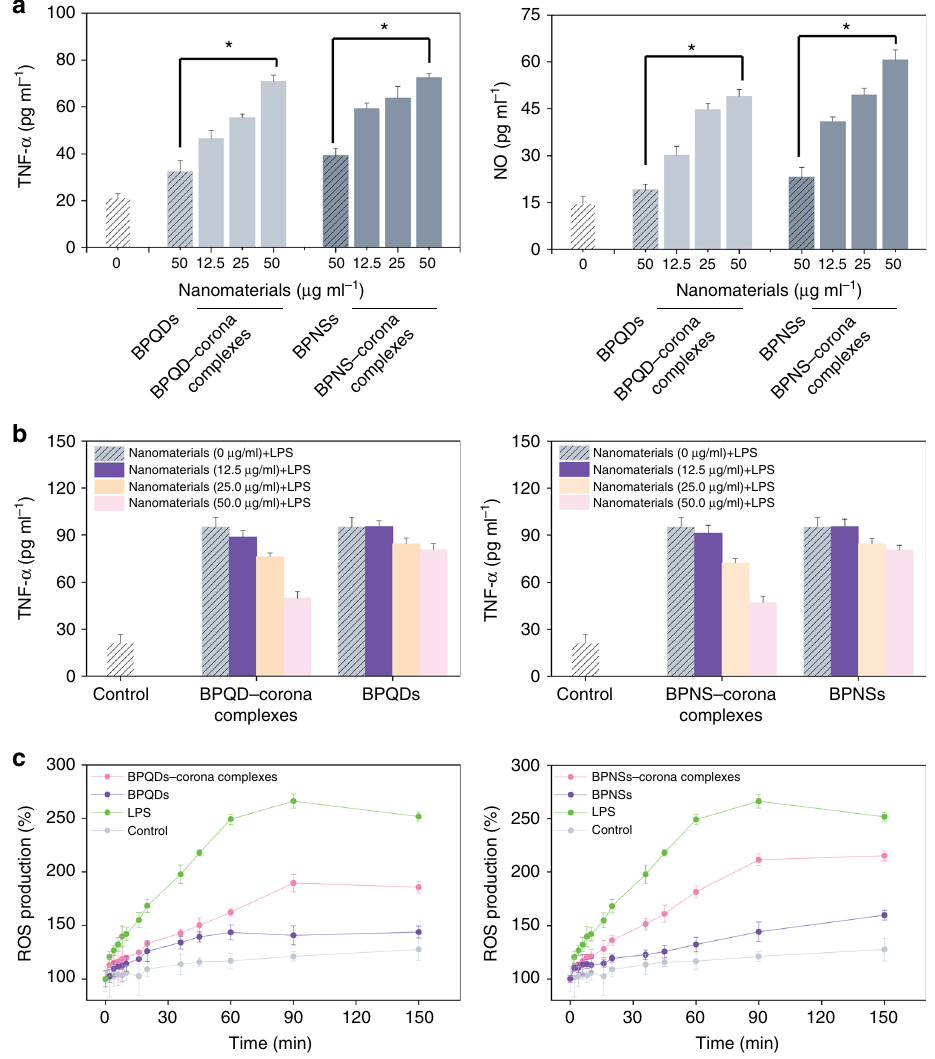
Fig. 6 Immune perturbation by BP – corona complexes in macrophages. a NO and TNF- α generation in dTHP-1 cells. Cells were treated with 50 μ g ml − 1 BP nanomaterials and an increasing concentration of corona complexes (12.5, 25 and 50 μ g ml − 1 ) for 6 h. Values are expressed as the means ± SDs of triplicates. Statistical signi fi cance is assessed by Student ’ s t test. * p < 0.05, ** p < 0.01. b TNF- α secretion in dTHP-1 cells. LPS (20 ng ml − 1 ) was added to the macrophages, which had been pretreated with BP nanomaterials or BP – corona complexes for 6 h. Values are expressed as the means ± SDs of triplicates. c ROS overproduction in macrophages exposed to 50 μ g ml − 1 BP nanomaterials or BP − corona complexes for 6 h. LPS (20 ng ml − 1 ) was set as the positive control. Values are expressed as the means± SDs of